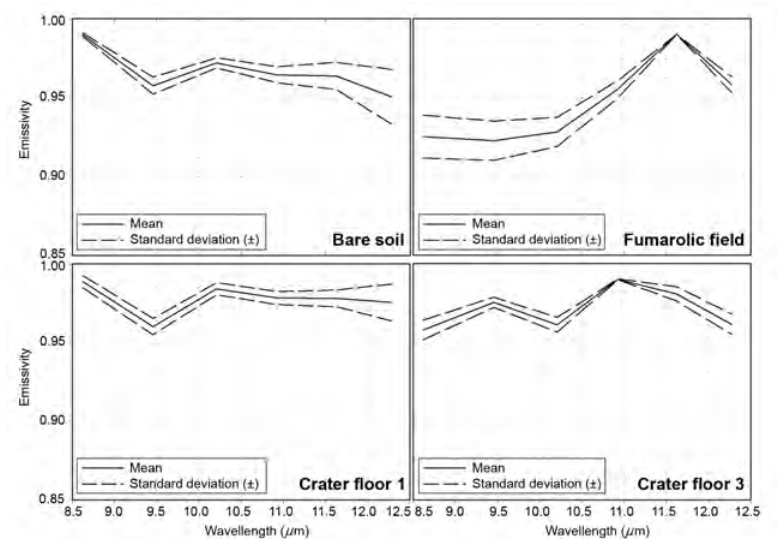
Fig. 7. Emissivity spectra retrieved from the DAIS data. Average values were calculated on regions of interest selected on the main surface